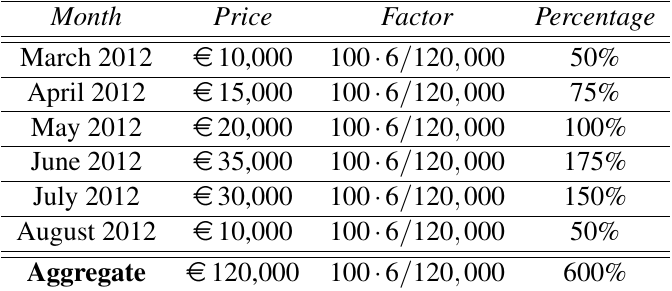
Table 1 Example of change in % of all the month production prices for a given promotion. Source: own elaboration. and time scale promotions (Peer, 1982 [17]; Kenley & Wilson, 1989 [12]; Blyth & Kaká, 2006 [3]). Following the above, the suggested methodological process is as